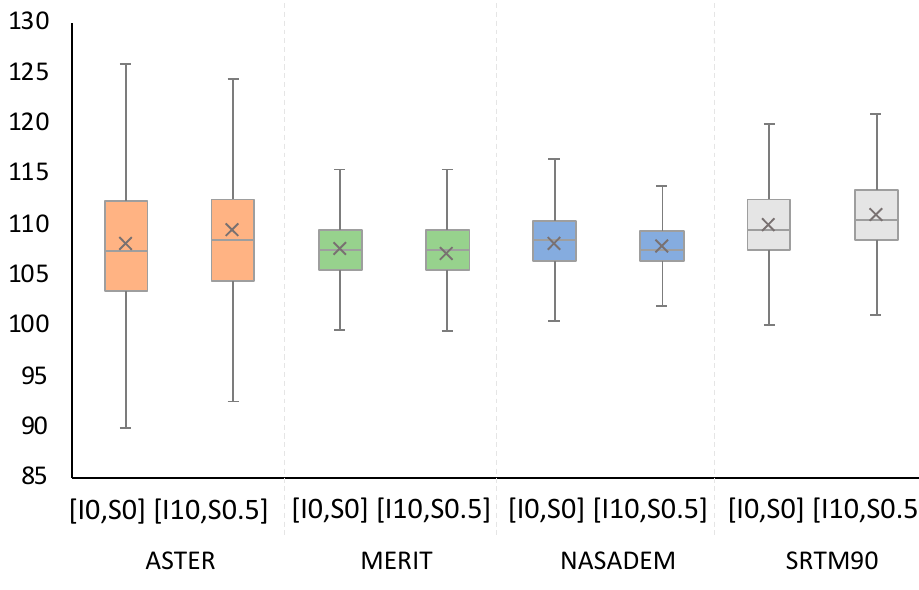
Figure 8. Water level (in meters) statistics in the form of boxplots (showing min, max, mean, Q25, Q50, and Q75) calculated from FwDET results on the four DEMs and 16 July 2019 flood map.